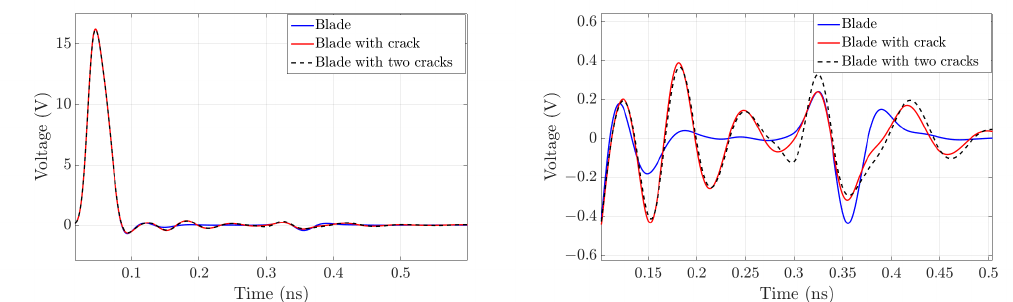
Figure 10. A comparison of the reflected voltage generated by a disconnected source in each of the three simple